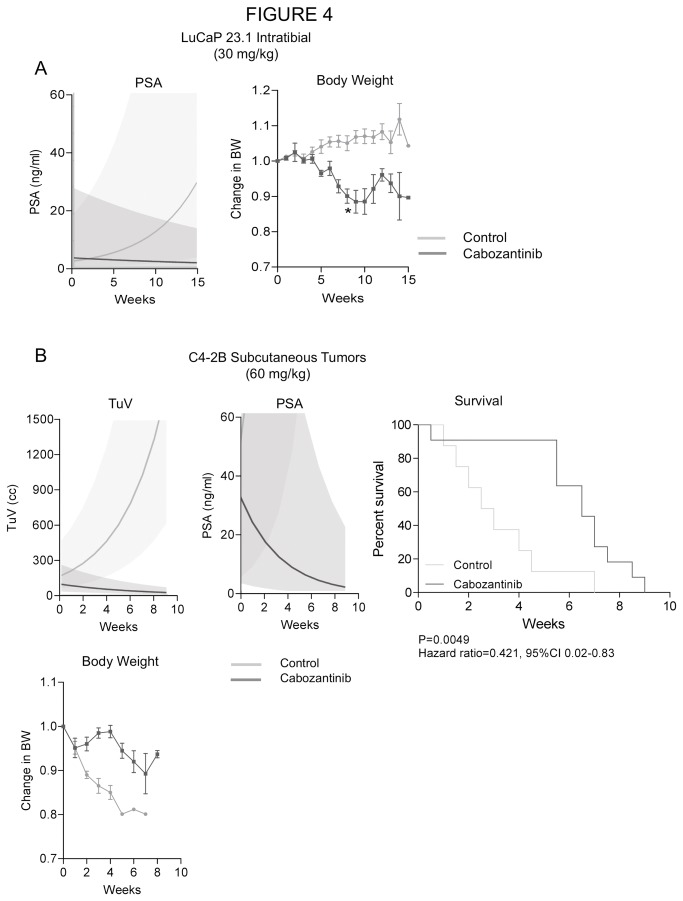
A. A lower dose of cabozantinib at 30 mg/kg also inhibits tumor progression as demonstrated by decreases in serum PSA in animals bearing LuCaP 23.1 tumors in the tibiae. The lower dose was well tolerated for 6 weeks of treatment with no significant body weight loss. Prolonged treatment (7–15 weeks) caused 7–11% body weight decreases which were, however, statistically significant (P=0.0002-0.04). Significance of the changes was determined by comparing enrollment BW to BW at each week using 2-sided t-test. Mean ± SEM is plotted. B. Cabozantinib treatment (60 mg/kg) inhibited tumor growth of subcutaneous castration-resistant C4-2B tumors as determined by TV and serum PSA levels. This treatment also significantly increases survival as determined by log-rank test. C4-2B tumor growth causes decreases of BW in the experimental animals (4–13%, P= 0.0001-0.003), and the cabozantinib treatment prevents this effect resulting in no significant BW loss. Significance of the changes was determined by comparing enrollment BW to BW at each week using 2-sided t-test. Mean ± SEM of the group is plotted.